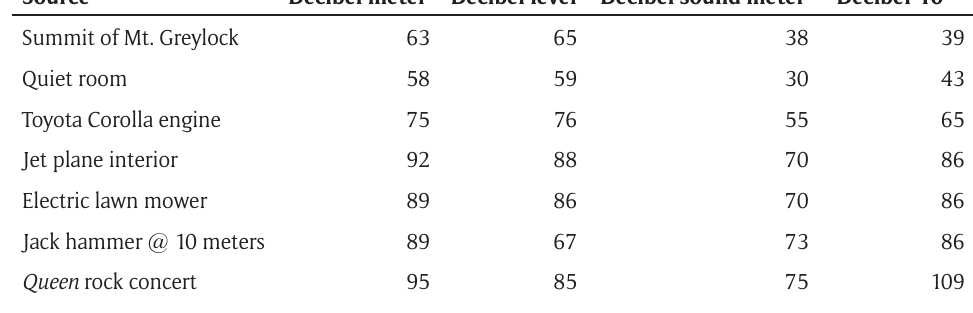
Table 4: Acoustic levels measured on an iPhone 6s at a variety of